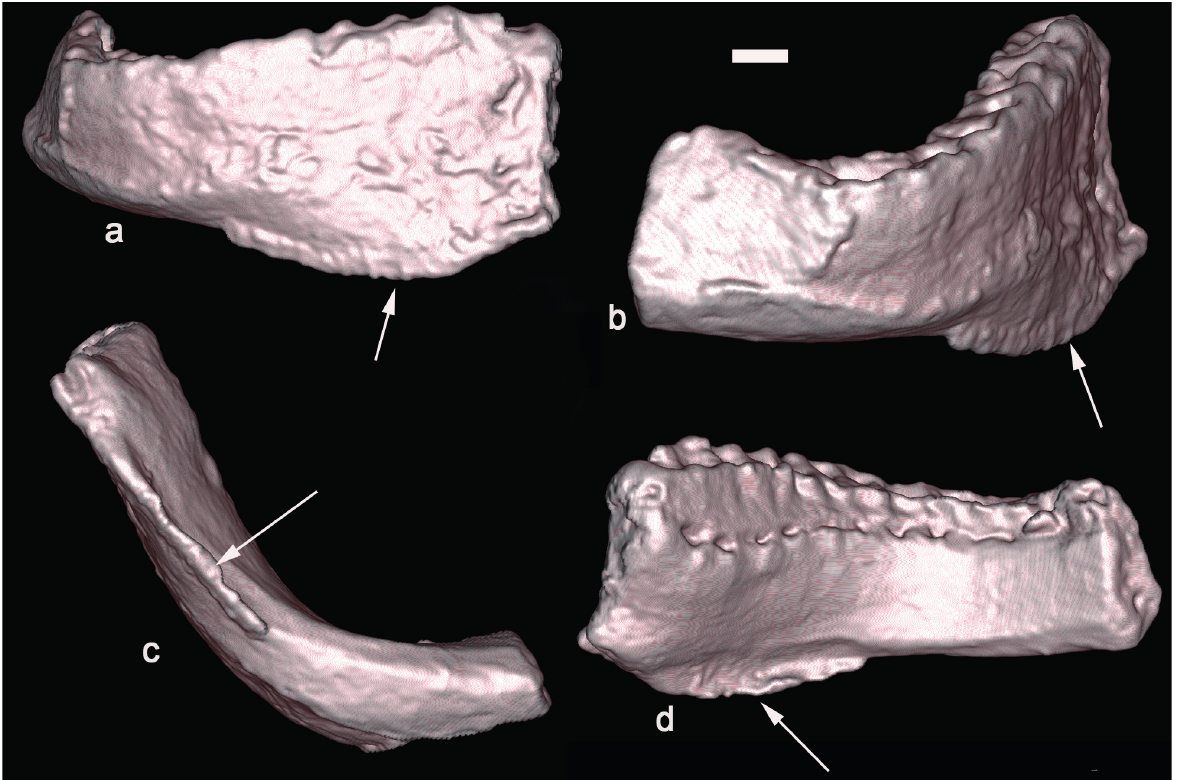
Figure 6 - Baalsaurus mansillai n.g.n.sp. a : anterior view, b : lateral view, c : ventral view and d : lingual view. Arrows point the